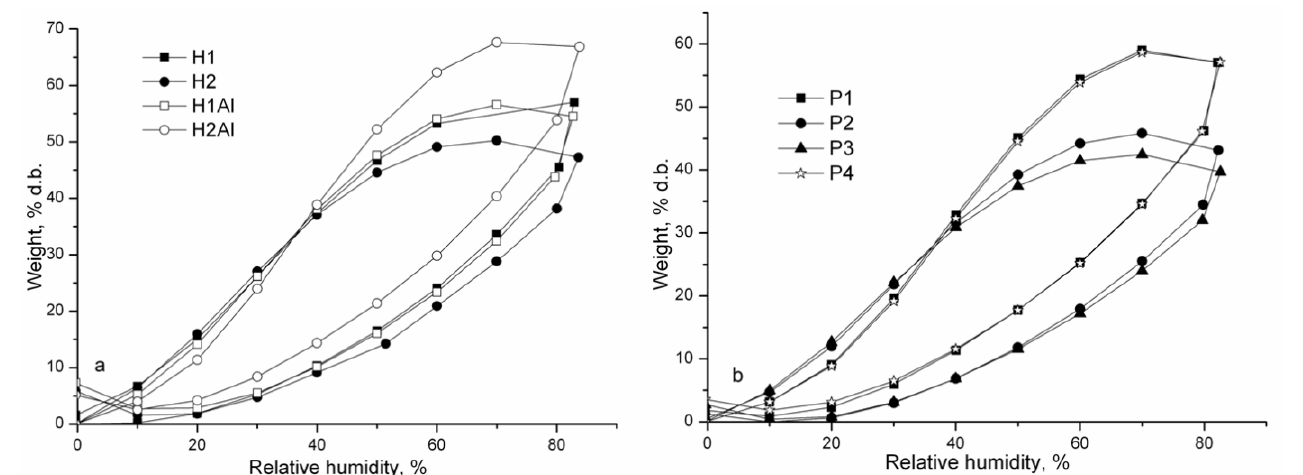
Figure 4. The sorption/desorption isotherms of studied hydrogels: a — H1, H2, H1Al, and H2Al samples; b — P1, P2, P3, and P4 samples. samples; b—P1, P2, P3, and P4